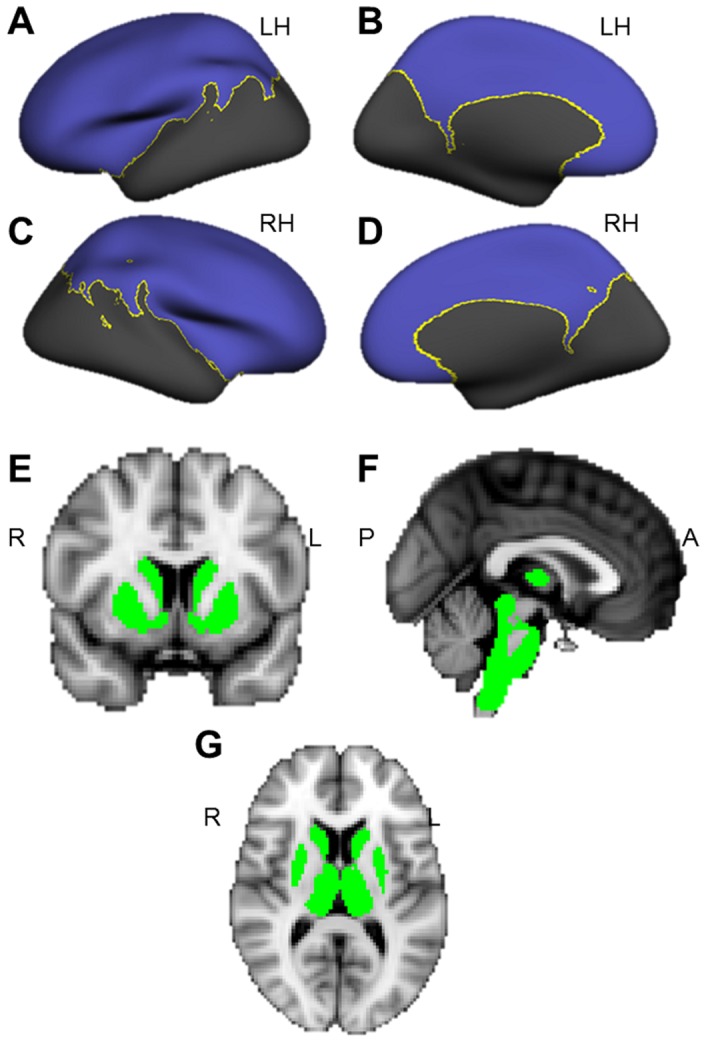
Analyses were restricted to gray matter masks.CTA and VBM gray matter analyses were restricted to masks. (A–D) Cortical thickness masks for the left (A & B) and right (C & D) hemispheres, including lateral (A & C) and medial (B & D) views. (E–G) VBM masks of subcortical structures in coronal (E), sagittal (F) and axial (G) views.